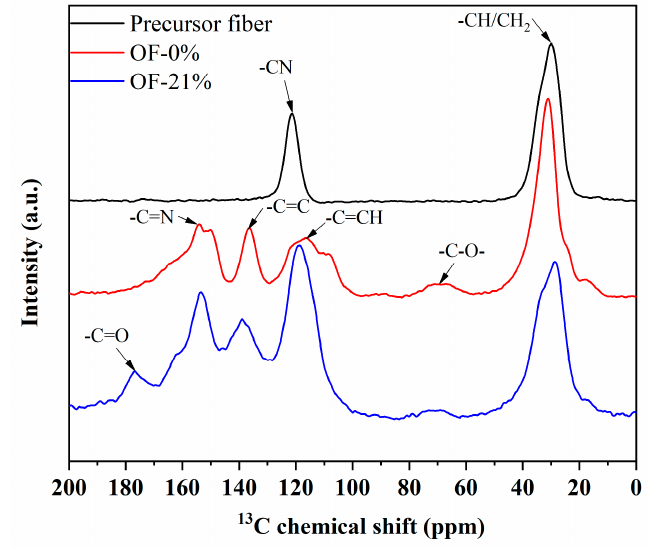
Figure 4. The 13 C-NMR characterization of the chemical structure of pre-oxidized fibers.